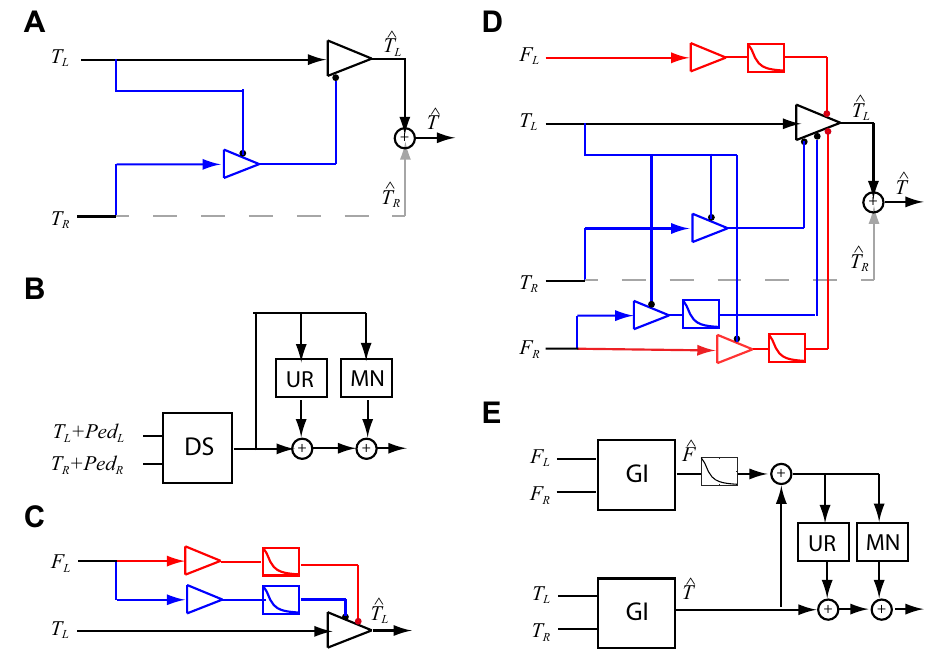
Figure 5. Models. ( A ) DS model: A gain-control model of binocular combination 4 , for target only or target + pedestal condition. Only half of the model is shown here, the other half is symmetric. ( B ) GUM model: DS gain-control model with stimulus-induced uncertainty reduction (UR) and multiplicative noise (MN). ( C ) A model with monocular flanker gain-control (blue) and gain-enhancement (red) of target. ( D ) GI model: DS gain-control model with flanker-target interactions. This is the best fitting model to the matching data (lines in Fig. 4 E